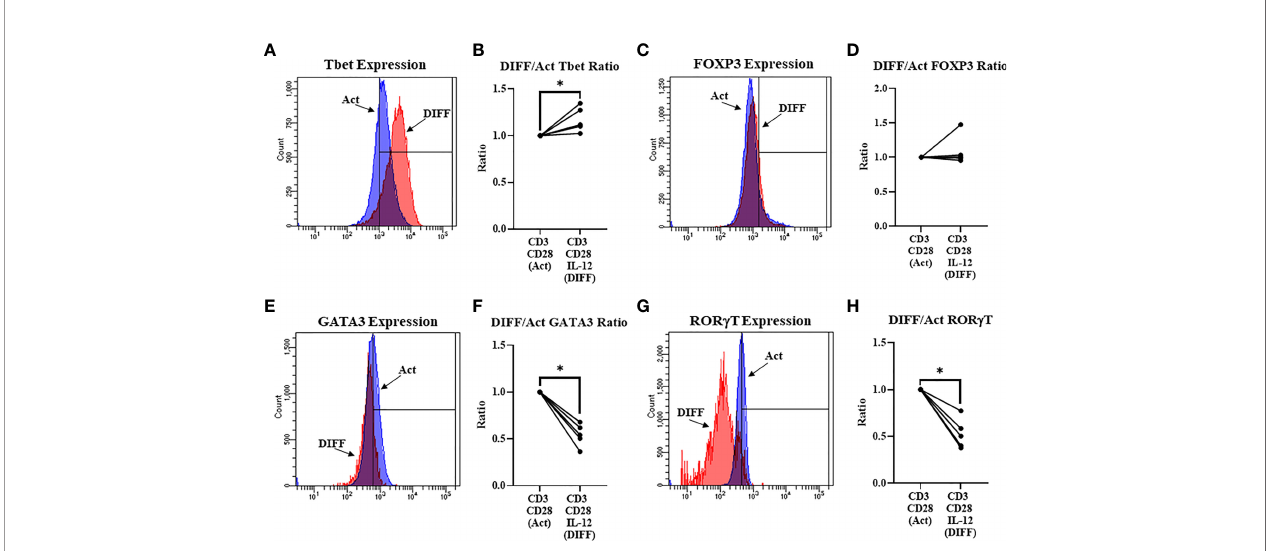
FIGURE 1 | Differentiation (Anti-CD3, Anti-CD28, & IL-12) of naïve CD4 + T cells. (A) Representative FACS histograms of Tbet expression in Act and DIFF CD4 + T cells (B) IL-12 increased the ratio of CD4 + T cells expressing Tbet. (C) Representative FACS histograms of FOXP3 expression in Act and DIFF CD4 + T cells. (D) IL- 12 had no effect on CD4 + T cells expressing FOXP3. (E) Representative FACS histograms of GATA3 expression in Act and DIFF CD4 + T cells. (F) IL-12 decreased the ratio of CD4 + T cells expressing GATA3. (G) Representative FACS histograms of RORgT expression in Act and DIFF CD4 + T cells. (H) IL-12 decreased the ratio of CD4 + T cells expressing RORgT. Act, Activation; DIFF, Differentiation. Data are average values for 3 independent experiments using CD4 + T cells from 5 donors. Signi fi cant differences (p<0.05) were detected using a paired T-test. *p ≤